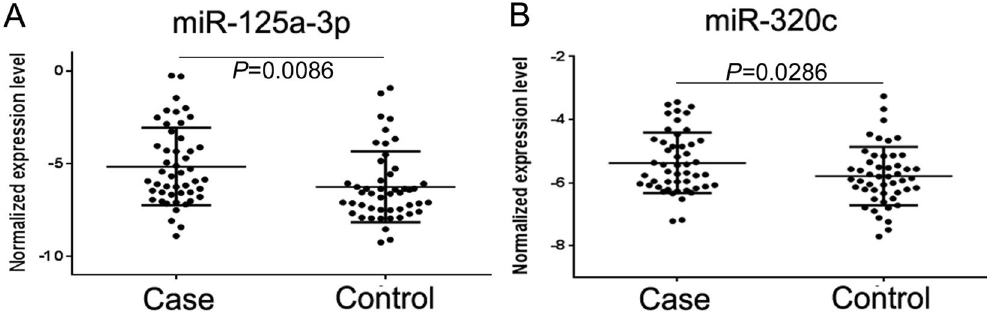
Figure 2. Expression levels of the miRNA candidates in the CRC patients and the healthy controls. A total of 3ng miRNA was reverse transcribed using QIAGEN miScript II RT kit. After 1:10 dilution, two microliters of cDNA template were used for quantification by real-time PCR. MiR-30e-5p was used as internal control. Relative expression levels of miR-125a-3p ( A ) and miR-320c ( B ) in the CRC patients (Case) and healthy controls (Control) are